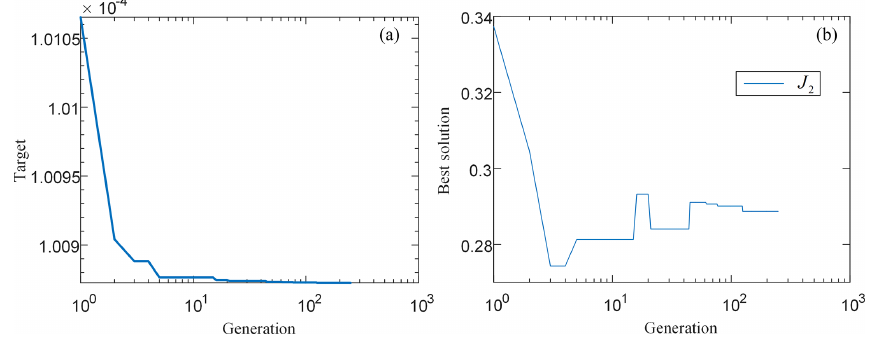
Figure 13. Identification process of moment of inertia. (a) The objective function changes with generations; (b) the elite individual changes with